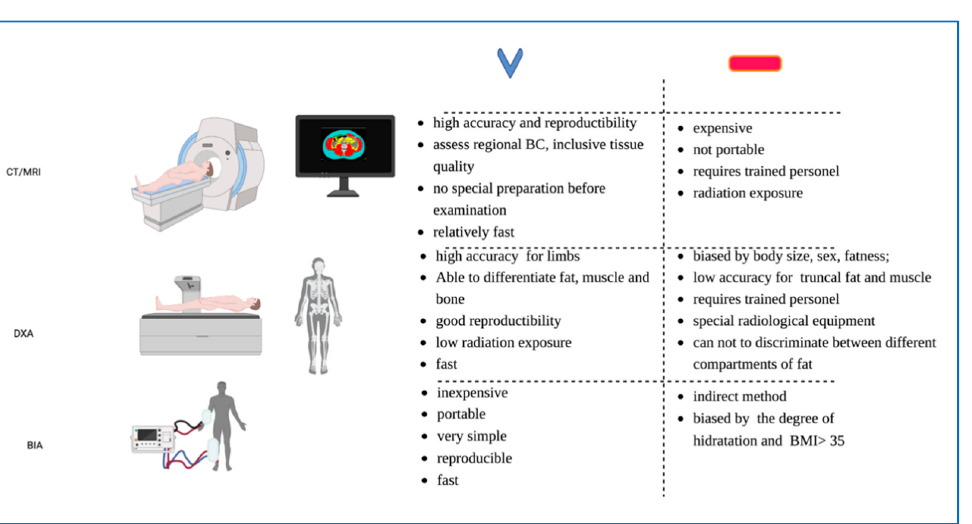
Figure 1. The most common methods for assessing body composition (equipment, advantages, and disadvantages).